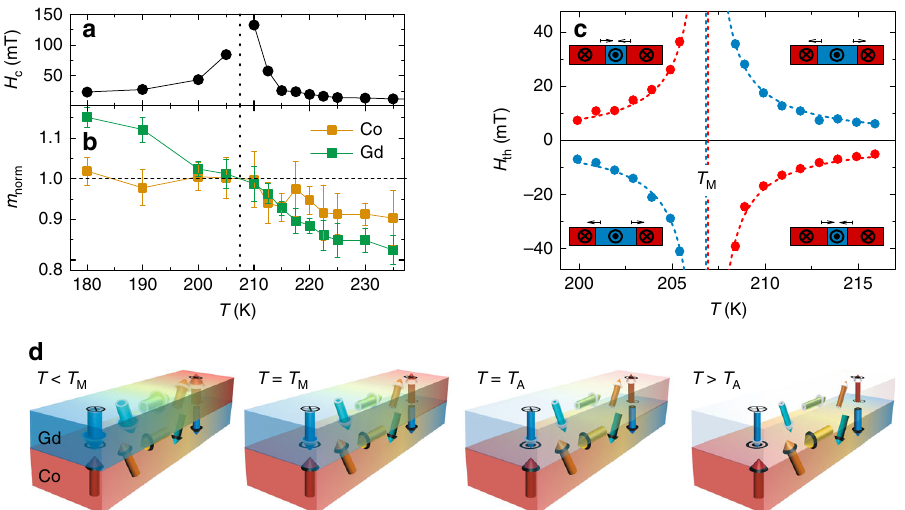
Fig. 1 Magnetic properties of ferrimagnetic bilayer. a Temperature-dependent coercivity of Gd loops. b Temperature-dependent magnetic moments of Co and Gd. Co and Gd magnetic moments are normalized to their respective values at the transition temperature of 207.5K. Error bar of the magnetic moments are estimated from the noise and non-linear background of the XMCD spectrum. c Threshold fi eld H t h at which the DWs start to move as a function of T (from Kerr microscopy). Red and blue dots indicate expansion of the up and down domains in the Co layer, respectively. Direction of DW motion is depicted in the inset in which the Co sublayer magnetization is shown. Dashed lines represent fi t to the data by a hyperbola. d Schematic illustration of the DW con fi guration in the Co and Gd layers at T < T M , T = T M , T = T A and T > T A . m Gd increases with decreasing T and compensates m Co at T